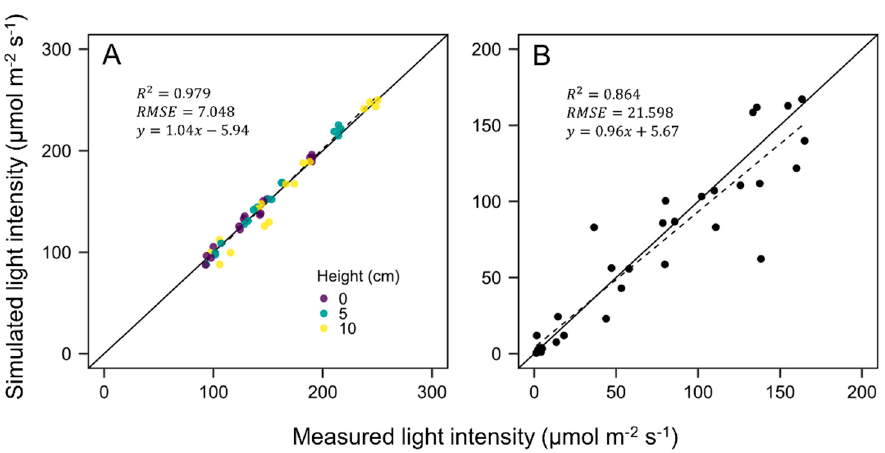
Figure 4. Comparison between measured and simulated light intensities in the empty chamber ( A ) and the chamber with lettuce plants or models ( B ). Light intensities in the empty chamber were measured and simulated at different heights from the floor of 0, 5, and 10 cm. Nine lettuce plants at 21 days after transplanting (DAT) were used.